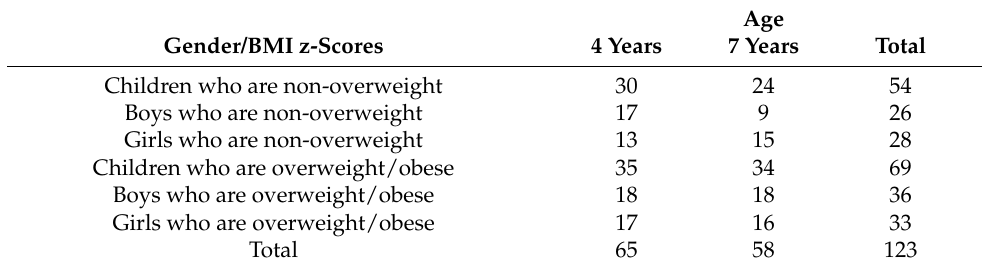
Table 1. Characteristics of the sample by